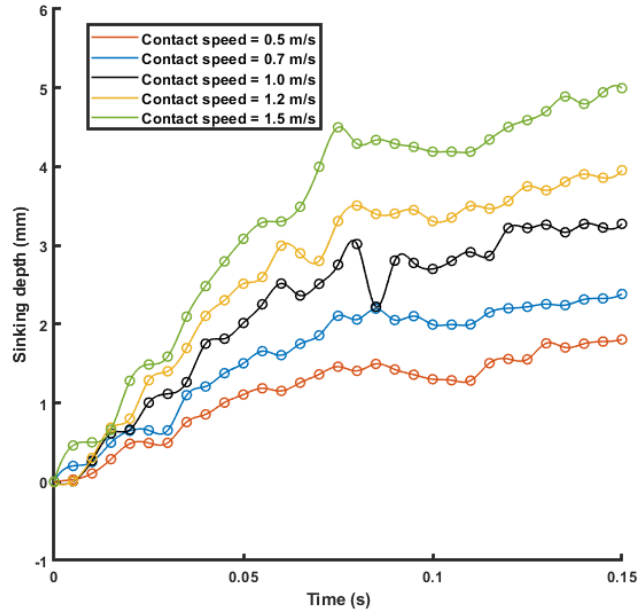
Figure 13. The speed versus time of the benthic lander sinking into the sediment.